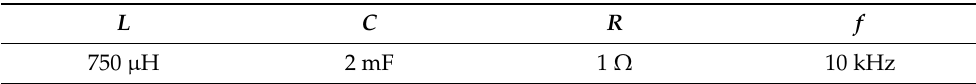
Figure 12. Simulink/Simscape model of the buck–boost converter. Table 3. Characteristics of the buck–boost